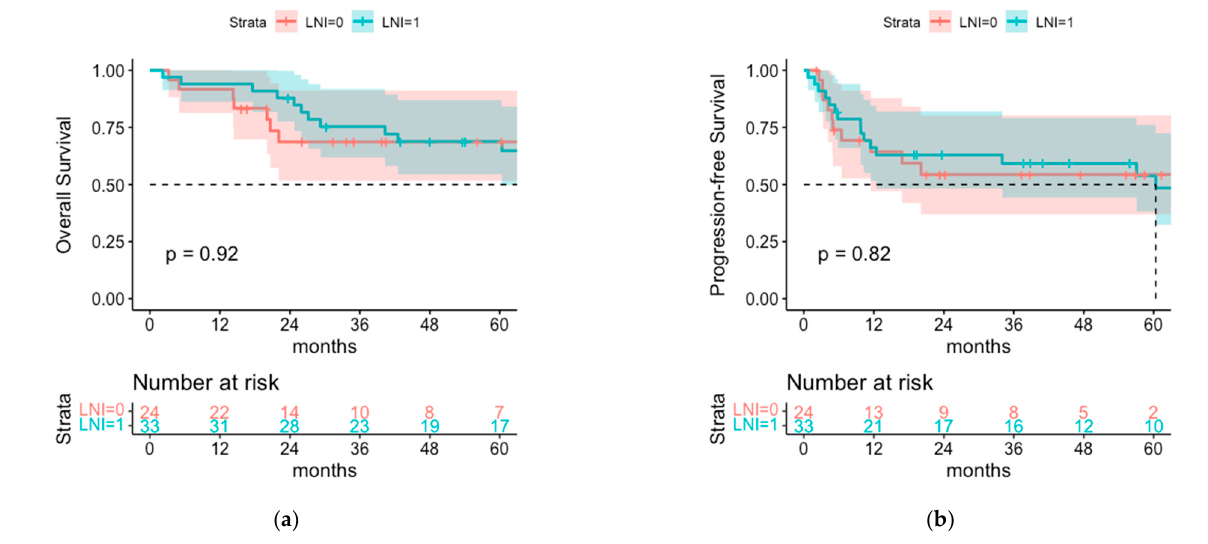
Figure 3. ( a ) OS and ( b ) PFS of patients who received postoperative radiotherapy of the tumor bed with additional lymph node irradiation (LNI = 1) or without lymph node irradiation (LNI = 0). Local recurrence (LR) was genuinely rare and occurred in one patient of each cohort (LR rate 3.0% in the LNI cohort versus 4.2% in the cohort without LNI). At the end of follow-up, the cumulative regional recurrence rate was 9.1% in the cohort with LNI (3/33 patients) and 25% in the cohort without LNI (6/24 patients). Distant recurrence was significantly more frequent observed in the LNI cohort (with higher AJCC stage) with a cumulative distant recurrence rate of 15.2% (5/33 patients) versus 0% in the cohort without LNI (0/24 patients, p = 0.049) (Table 2). This results in 85.7% of relapses being localized in the regional nodes (6/7) in the cohort without LNI versus 37.5% (3/8) of relapses being localized in the regional nodes in the cohort with LNI ( p = 0.11) and a relative risk of 2.28 for relapse located in the regional nodes for the cohort without LNI. Table 2. Sites of relapse for the total cohort and the cohorts with or without irradiation of regional lymph nodes (LNI) in absolute and relative frequencies. One patient experienced local and regional failure simultaneously (in the cohort without LNI), two patients experienced regional and distant failure simultaneously (both in the LNI cohort).